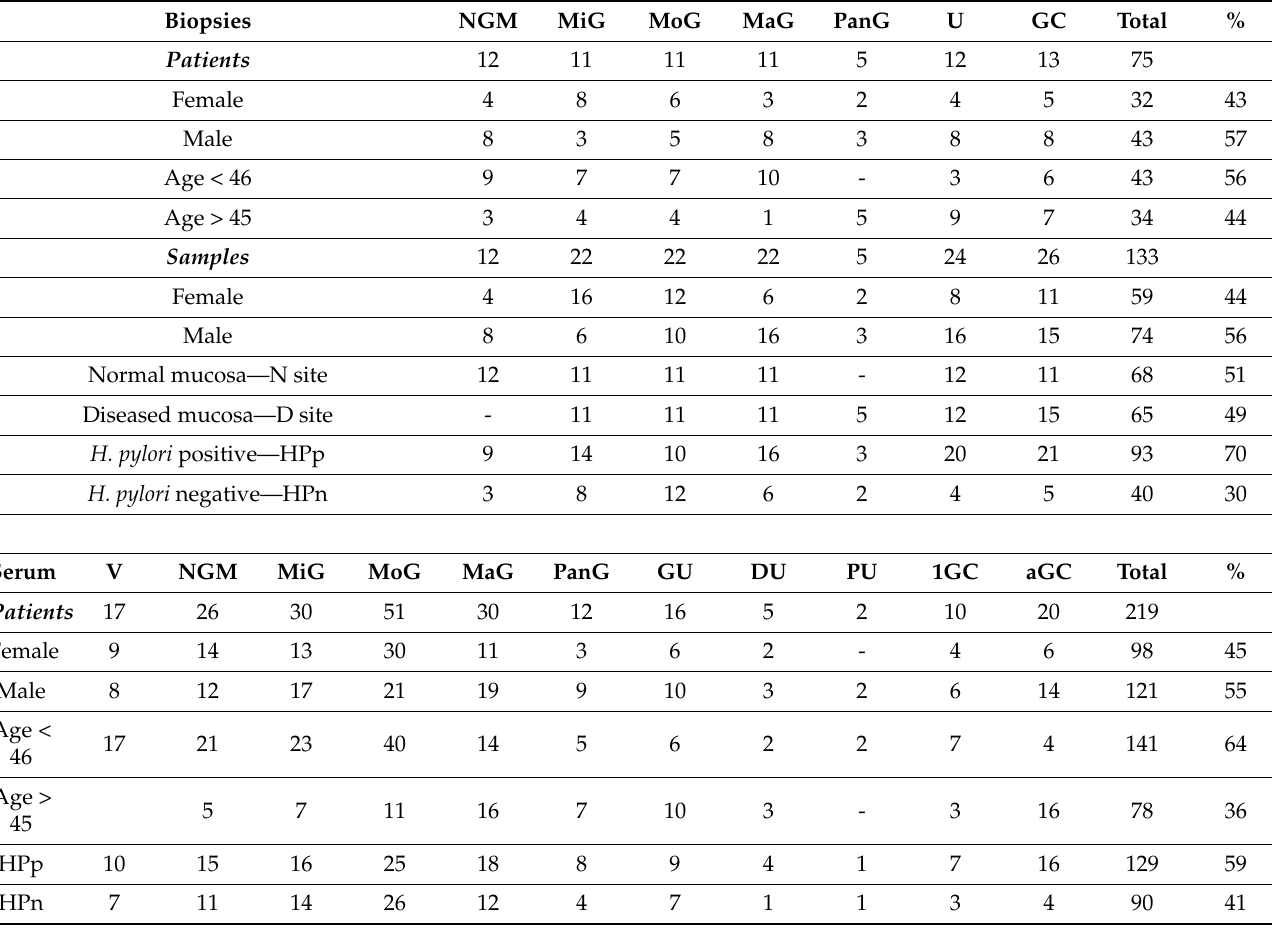
Table 1. Patient information. GU—gastric ulcer, DU—duodenal ulcer, PU—peptic ulcer, 1GC—1st stage GC, aGC—advanced